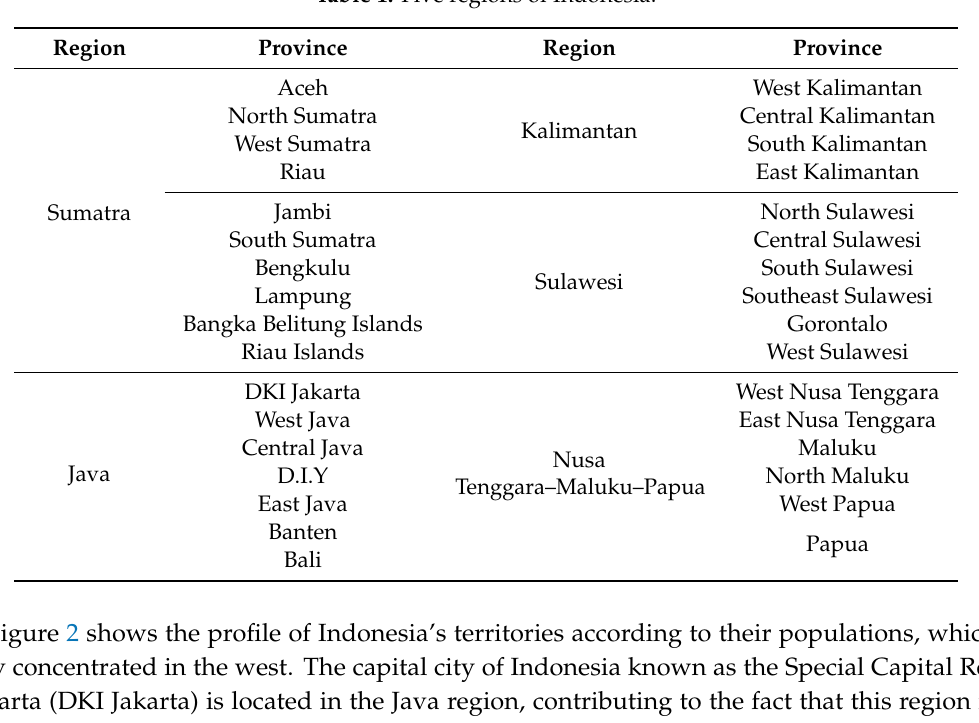
Table 1. Five regions of Indonesia.